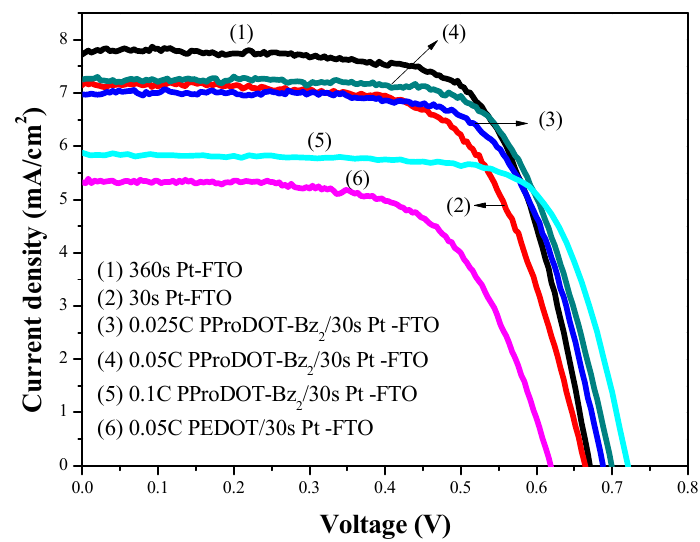
Figure 3. J–V curves of the DSSCs based on 360 s Pt, 30 s Pt, 0.025 C/cm 2 PProDOT-Bz 2 /30 s Pt, 0.05 C/cm 2 PProDOT-Bz 2 /30 s Pt, and 0.1 C/cm 2 PProDOT-Bz 2 /30 s Pt counter electrodes, respectively. The DSSC electrolyte is based on 0.6 M DMPII, 0.5 M LiI, 0.05 M I 2 , and 0.5 M TBP in 15 mL MPN. Table 1. The photovoltaic parameters of DSSCs with various counter electrodes. Counter